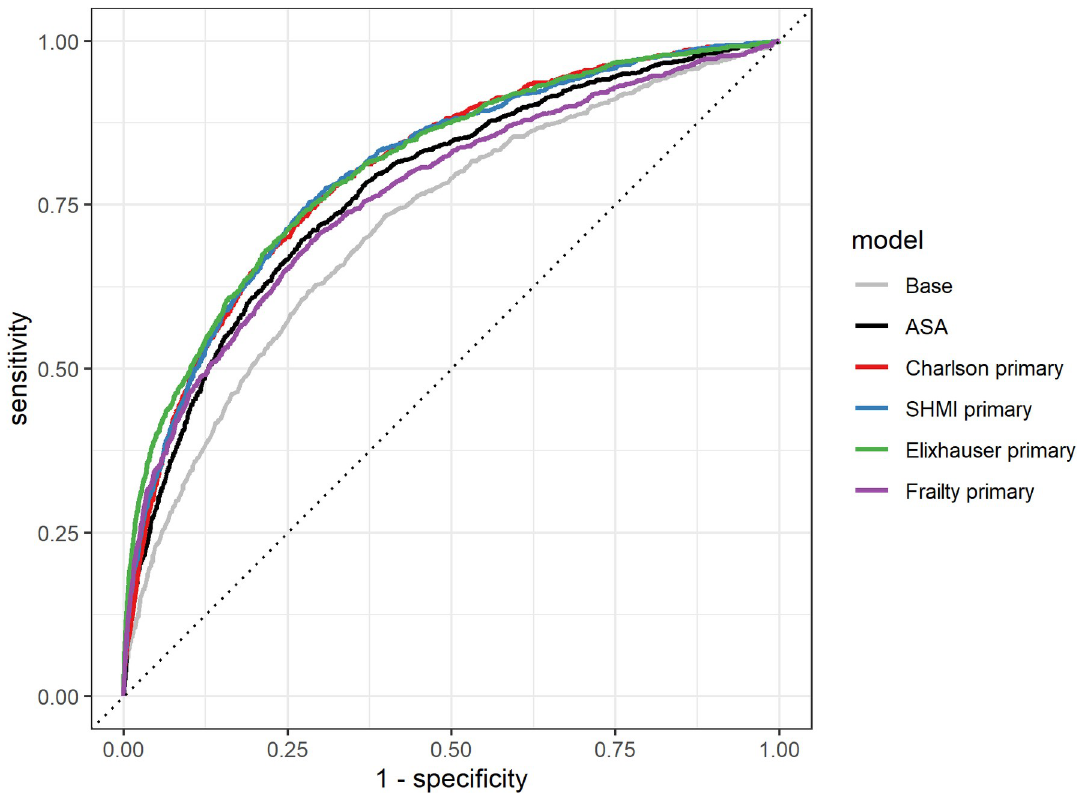
Fig 5. ROC curves for models of 90-day mortality after THR with base model, ASA grade and the 4 comorbidity indices derived using conditions recorded at the time of the primary, including age and gender.